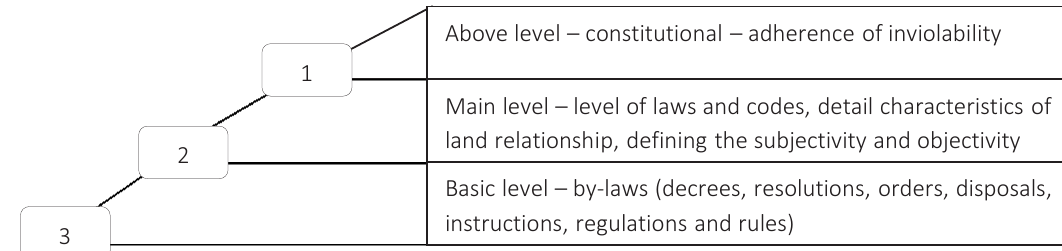
Figure 3. The system structure of normative and legal regulation of land relationship